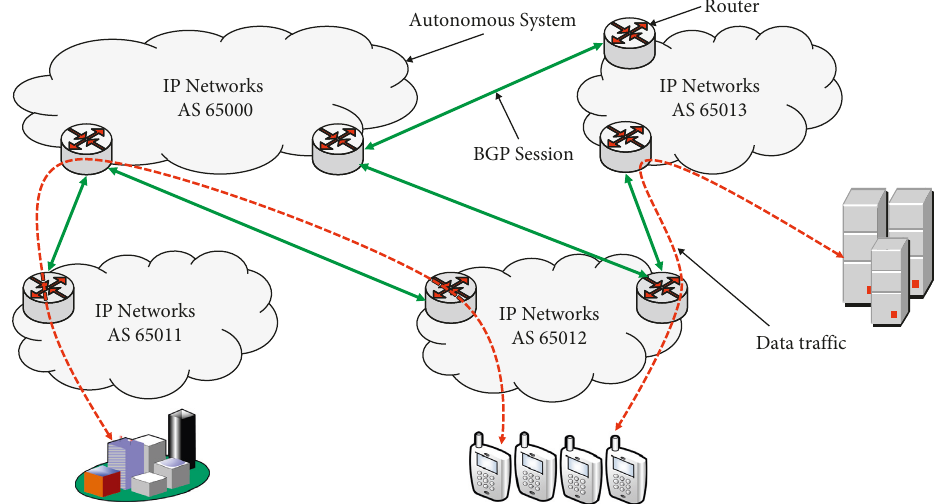
Figure 1: Enabling BGP-4 in a network